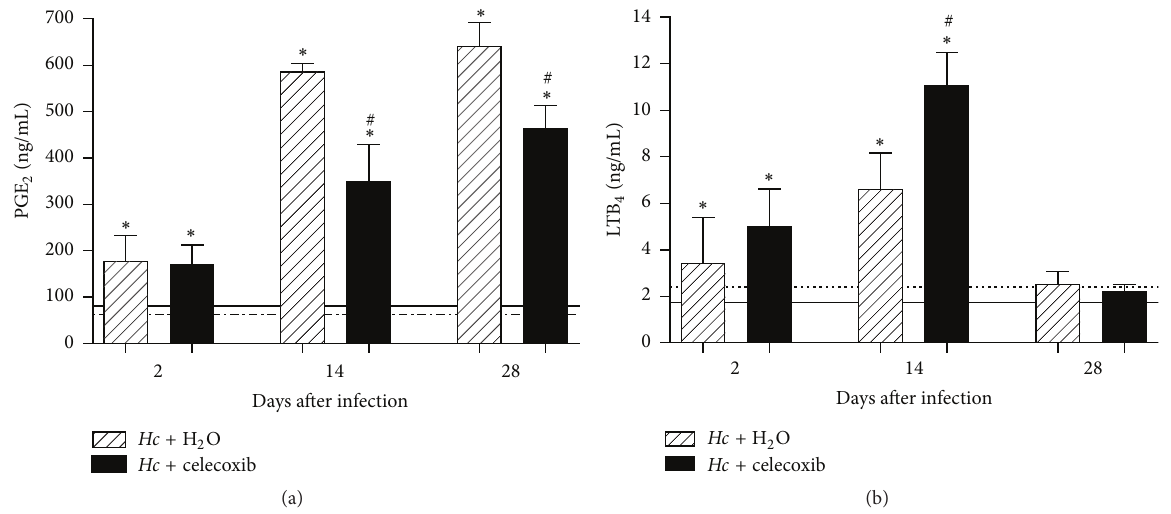
Figure 3: Celecoxib treatment modulates endogenous PGE 2 and LTB 4 production in the lungs of H. capsulatum -infected mice. Lipid mediators in the lung parenchyma were measured using enzyme immunoassay (a) PGE2, (b) LTB4. The lungs of mice infected i.t. with sublethal H. capsulatum inoculum and daily p.o. treatment with water or celecoxib (1mg/kg/0.5mL) were removed at 2, 14, or 28 days after infection and homogenized in medium in the presence of indomethacin. A group of noninfected mice receiving water (solid line) and noninfected mice treated with celecoxib (dotted line) were used as controls. The data are presented as the means ± SEM representative of three independent experiments (𝑛 = 5 - 6) . One-way ANOVA (Tukey’s multiple comparison test) was used. ∗ PBS + H 2 O versus Hc + H 2 O or versus Hc + celecoxib; # Hc + H 2 O versus Hc + celecoxib 𝑃 < 0.05